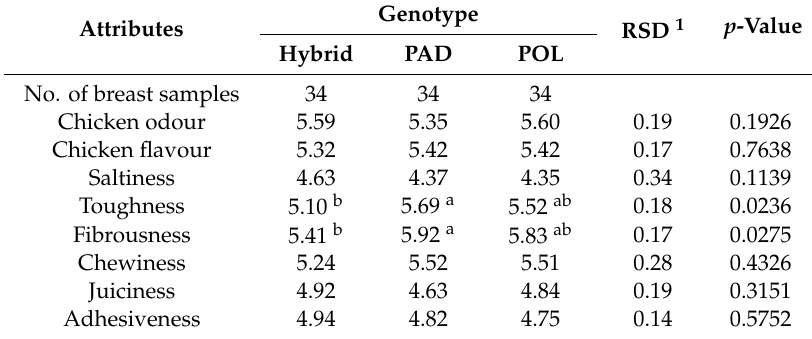
Table 4. Descriptive sensory analysis scores of breast meat according to genotype (Hybrid, PAD, POL). Genotype Attributes RSD 1 p -Value